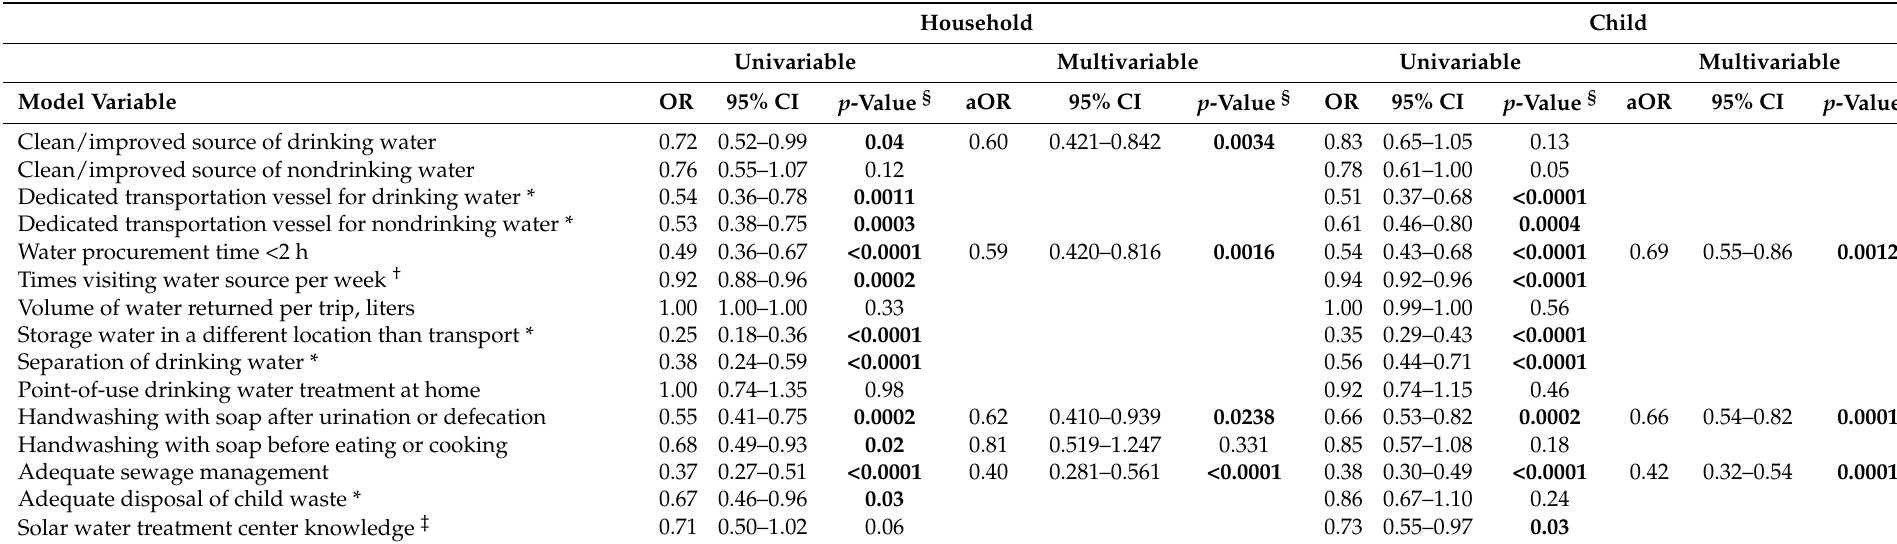
Table 3. Predictors of diarrhea in under-five children, by household and by child (OR > 1 implies increased risk of diarrhea). Household Child Univariable Multivariable Univariable